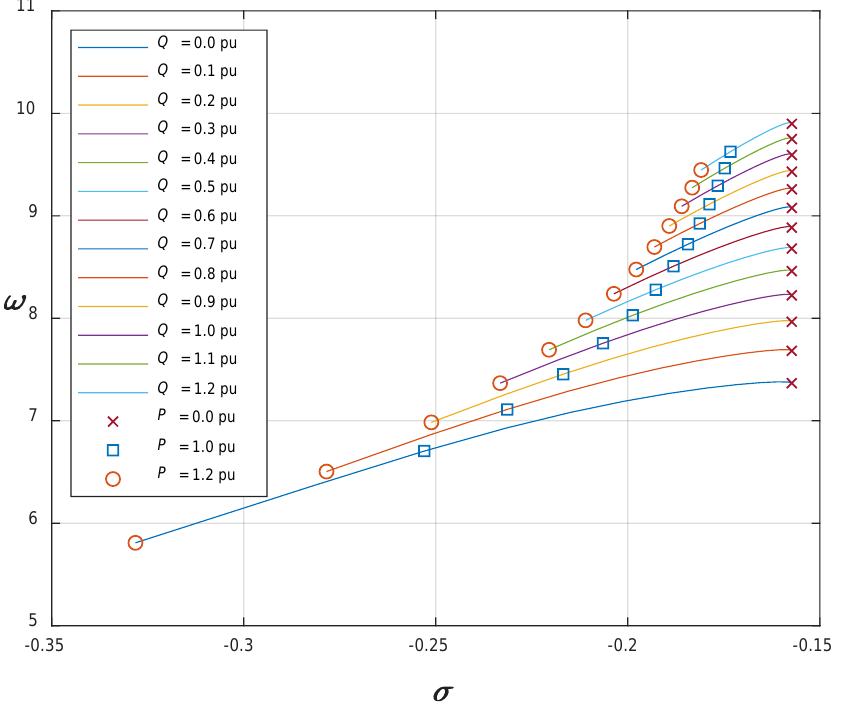
Figure 2. Eigenvalue loci of local mode of 12-MVA hydro-type synchronous generator without AVR.